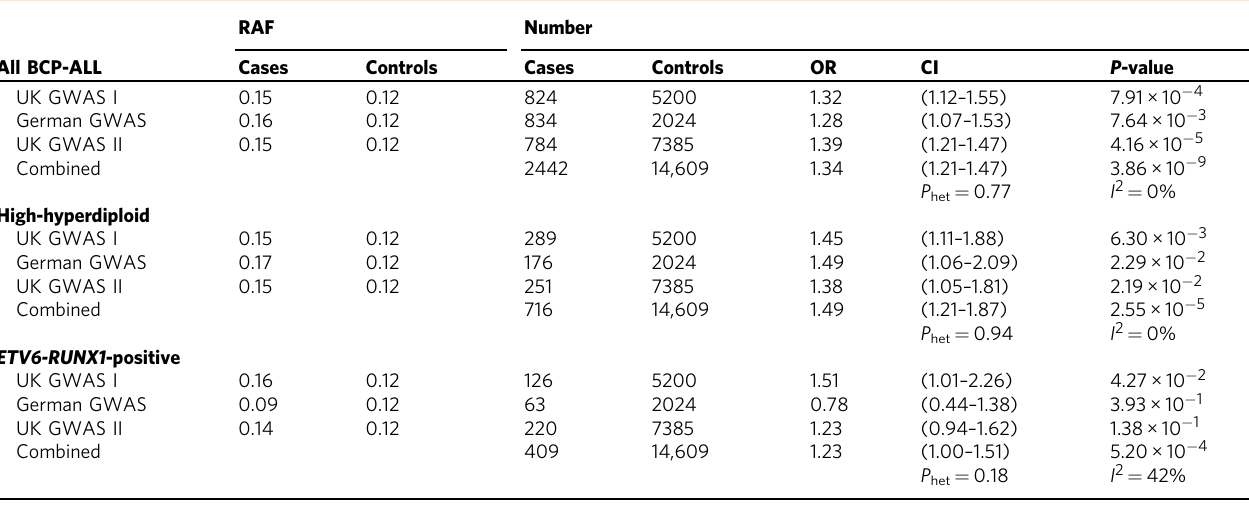
Table 1 rs28665337 (8q24.21) genotypes and risk associated with BCP-ALL, high-hyperdiploid, and ETV6-RUNX1 -positive childhood BCP-ALL subtypes